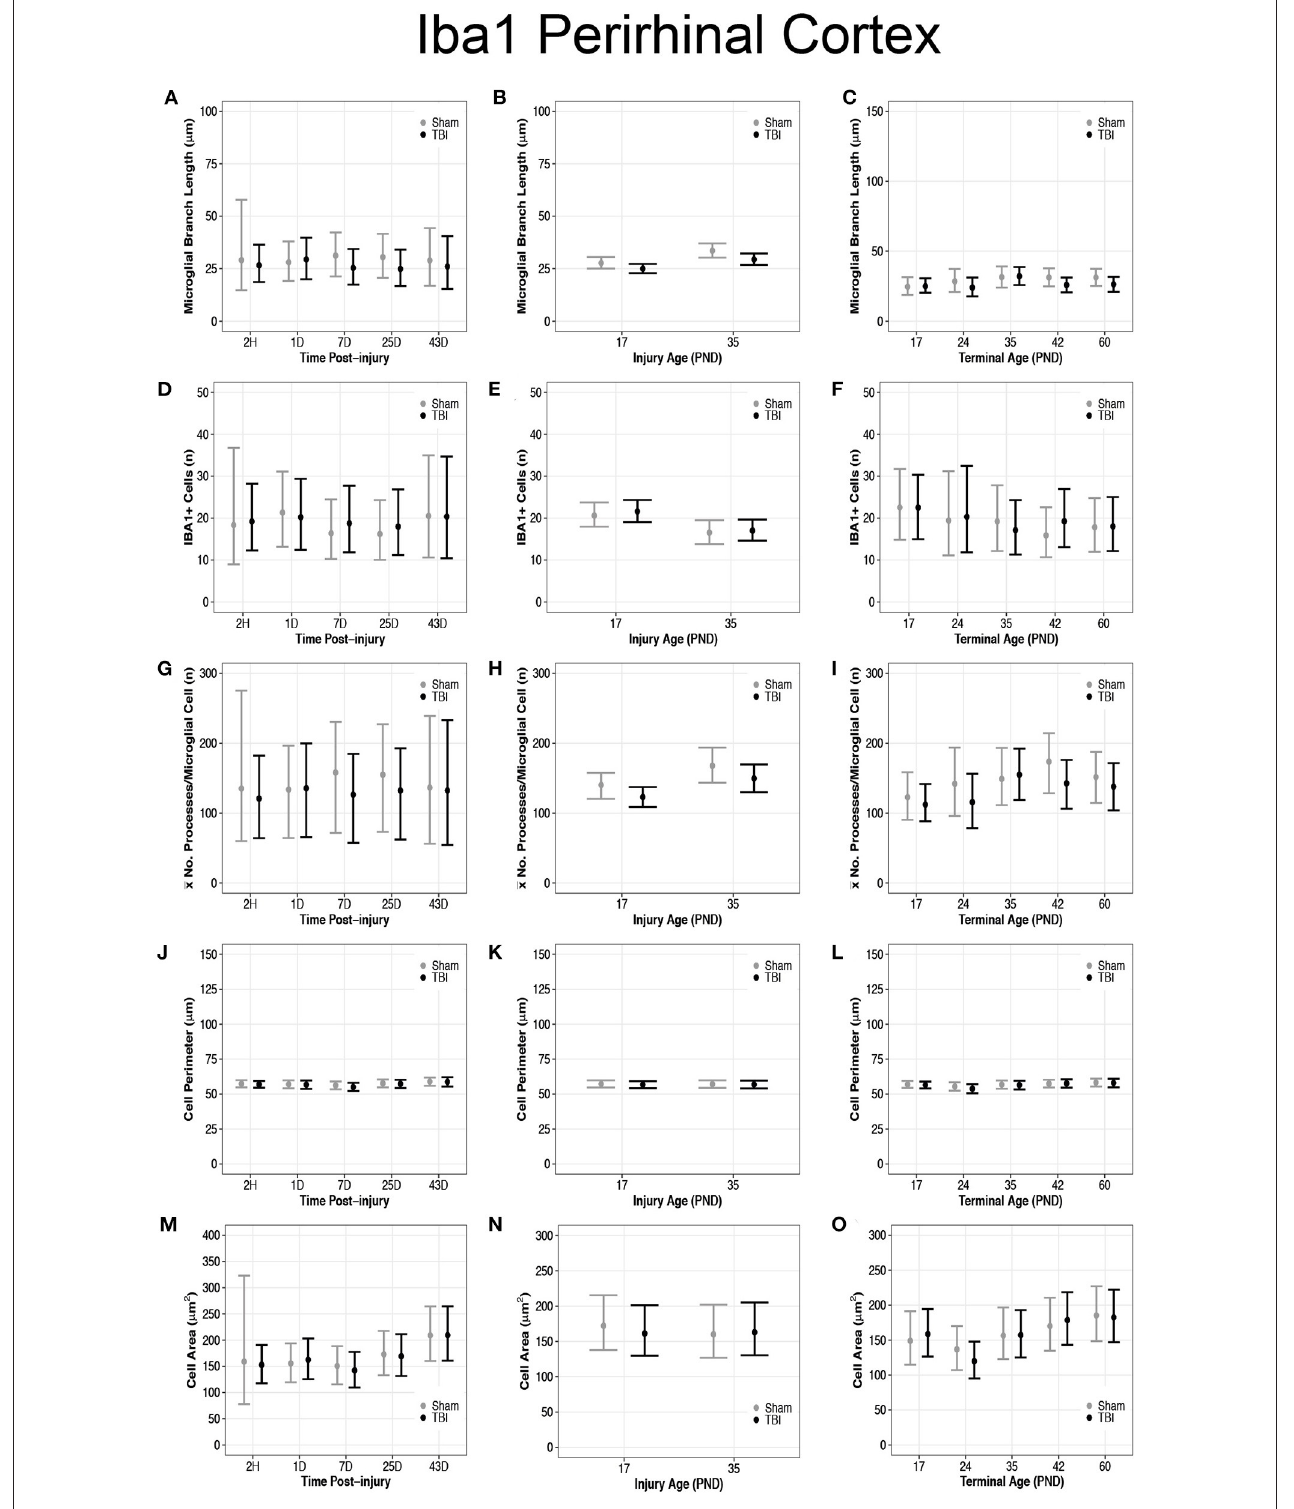
FIGURE 5 | Diffuse TBI activated microglia in the perirhinal cortex of rats injured at PND17 and PND35. Point estimates (posterior means) and corresponding 95% credible intervals (highest posterior density intervals) are presented. (A) There were no differences in microglial branch lengths between sham and TBI across